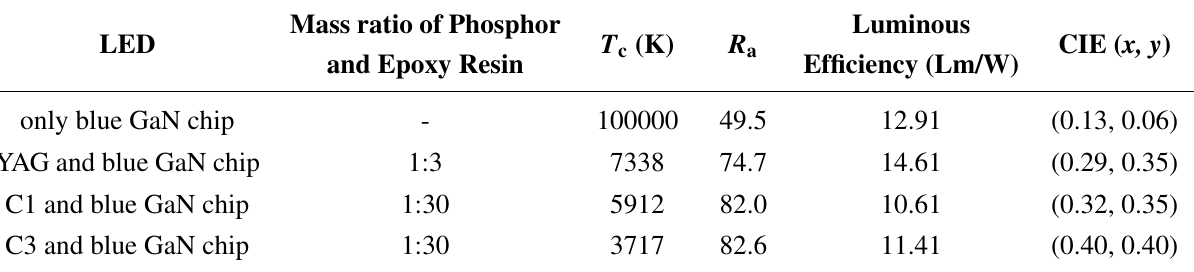
Figure 7. EL spectra of several LEDs at 20 mA forward bias: ( a ) The original blue GaN chip without phosphor ( b ) Blue GaN chip and YAG as phosphor ( c ) Blue GaN chip and complex C1 as phosphor ( d ) Blue GaN chip and complex C3 as phosphor. Table 1. Performances of LEDs under 20 mA current excitation.